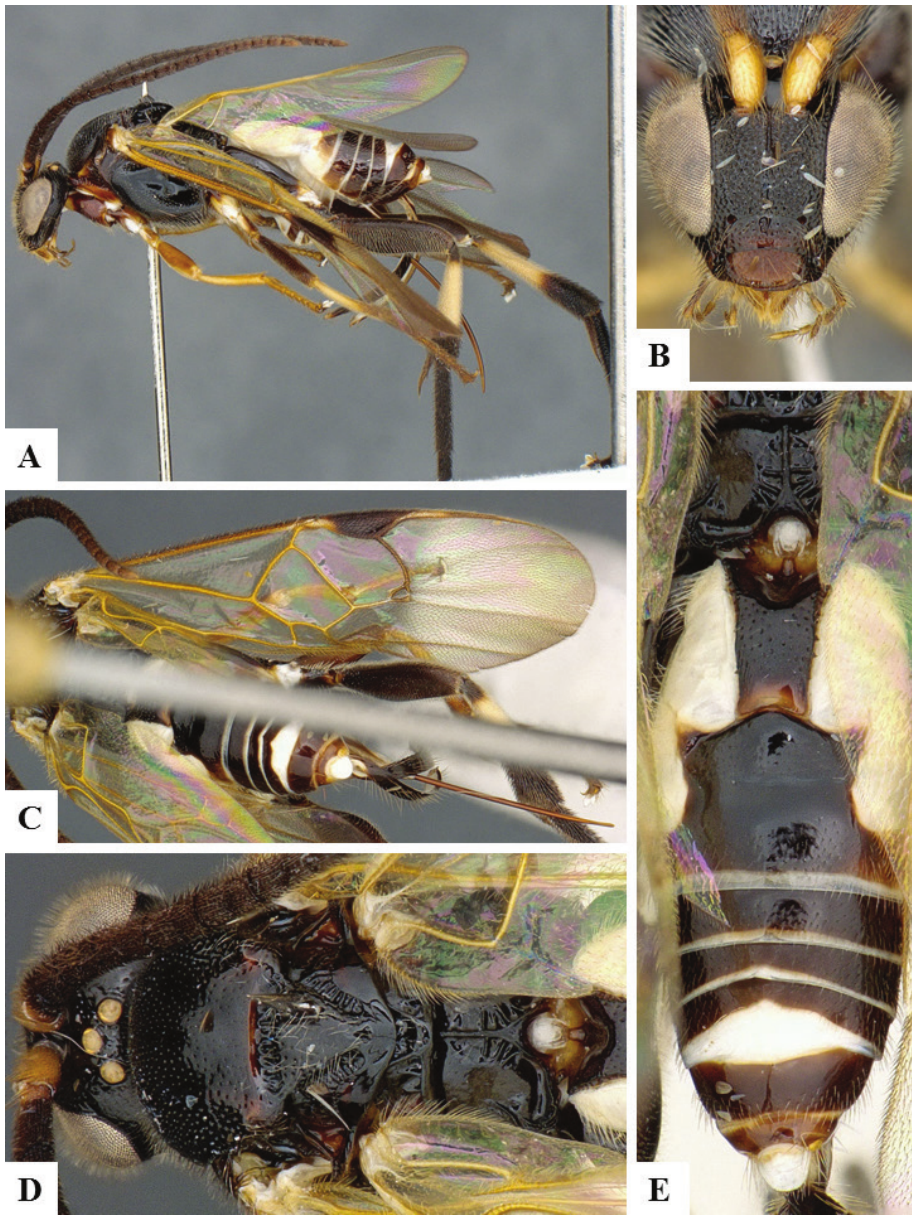
Figure 7. Agupta solangeae female holotype. A Habitus B Head frontal C Fore wing D Head and meso- soma, dorsal E Propodeum and metasoma, dorsal. central sulcus; posterior half punctured and a polished area on posterior margin. Hy- popygium folded and with several pleats. Ovipositor sheaths setose and slightly longer than metatibia length. Female body measurements (mm). F2 L: 0.43